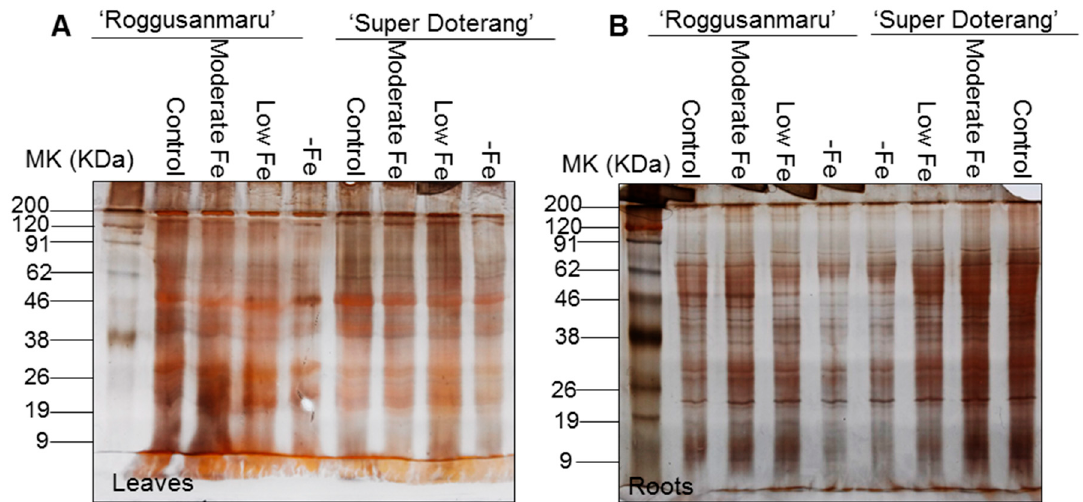
Figure 5. Total protein profile in ( A ) leaves and ( B ) roots of “Roggusanmaru” and “Super Doterang” tomato cultivar. Plants were grown in Fe-sufficient (control); moderate Fe; low Fe; and Fe-deficient (–Fe) hydroponic media for 10 days. Proteins extracted from shoots and roots were run on 12.5% polyacrylamide gel electrophoresis and stained with silver stain (MK on gels denote molecular marker).